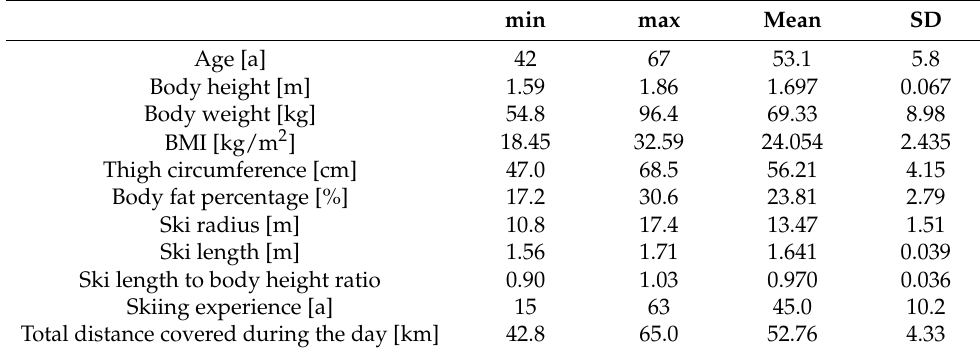
Figure 3. ( a ) The MVC values of the quadriceps and hamstring groups of all participants and the trendline with respect to the participant’s body mass indexes. ( b ) The normalised mean muscular activity over all reference runs of the day for the four muscle groups and all participants. Table 1. Characteristics of the study participants and their respective ski ( n = 38).